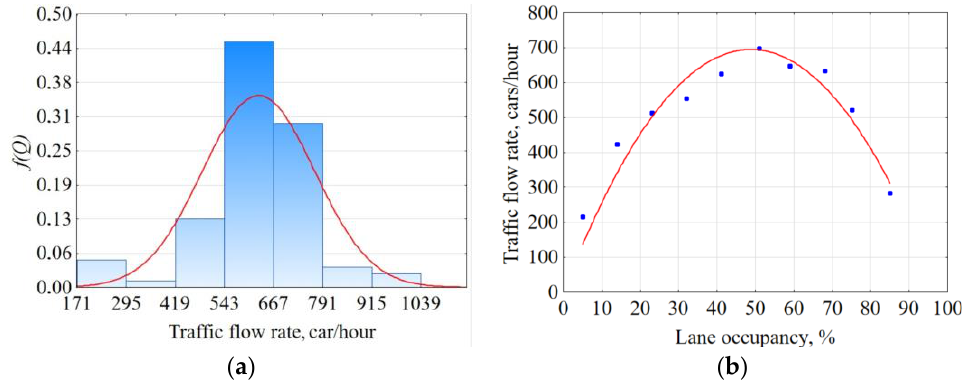
Figure 9. The histogram and the corresponding distribution function. ( a ) The regularity of the influence of lane occupancy on the traffic flow rate. ( b ) For the traffic lights’ operating mode from 09:00 to 15:00 and from 19:00 to 23:00, λ = 0.38.